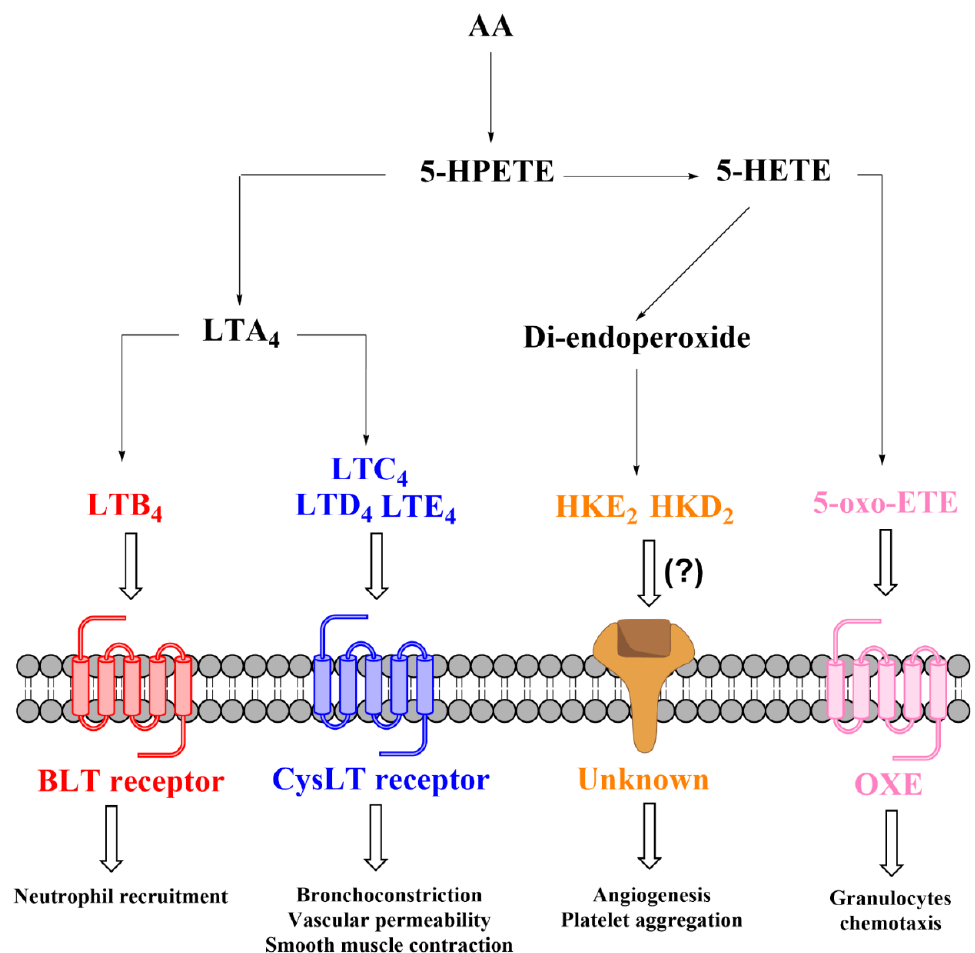
Figure 5. Biological effects of 5-LOX-derived eicosanoids.